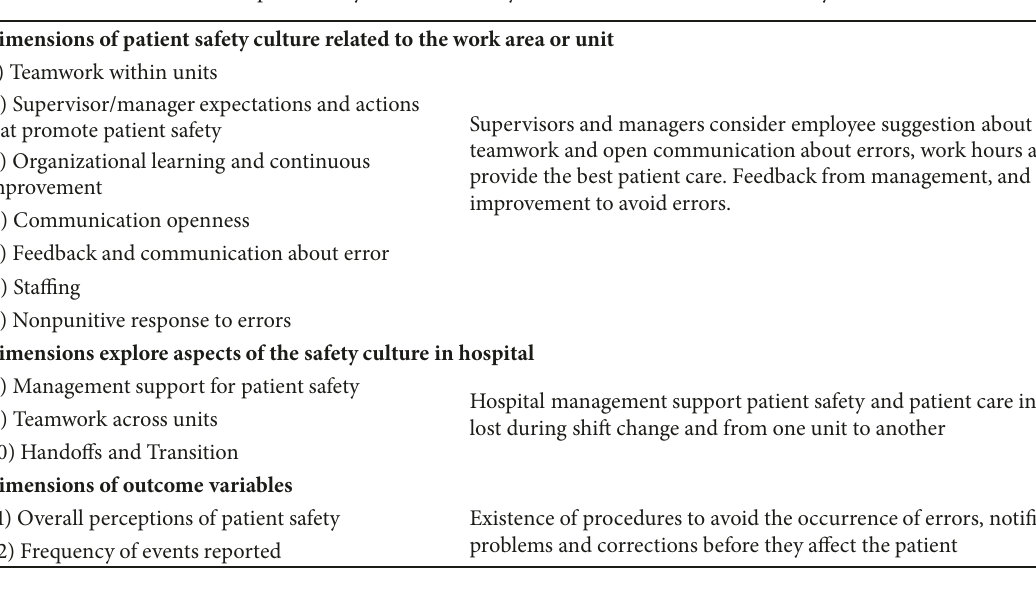
Table 1: Hospital Survey on Patient Safety Culture dimensions and what they are intended to